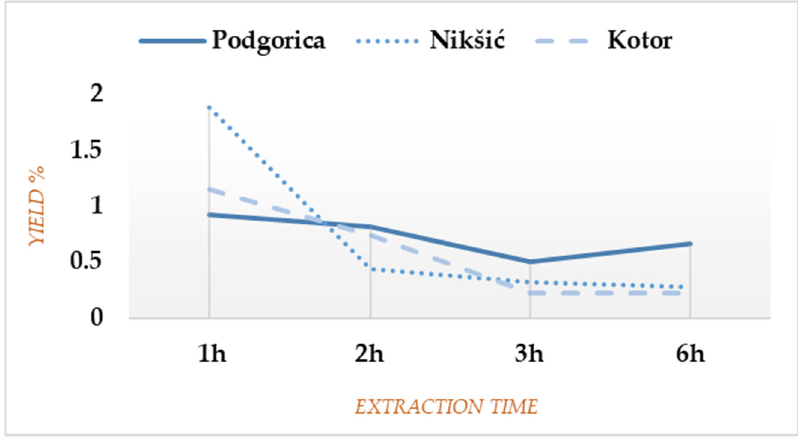
Figure 1. Yield curves for Foeniculum vulgare Miller (FV) from three Montenegrin localities.